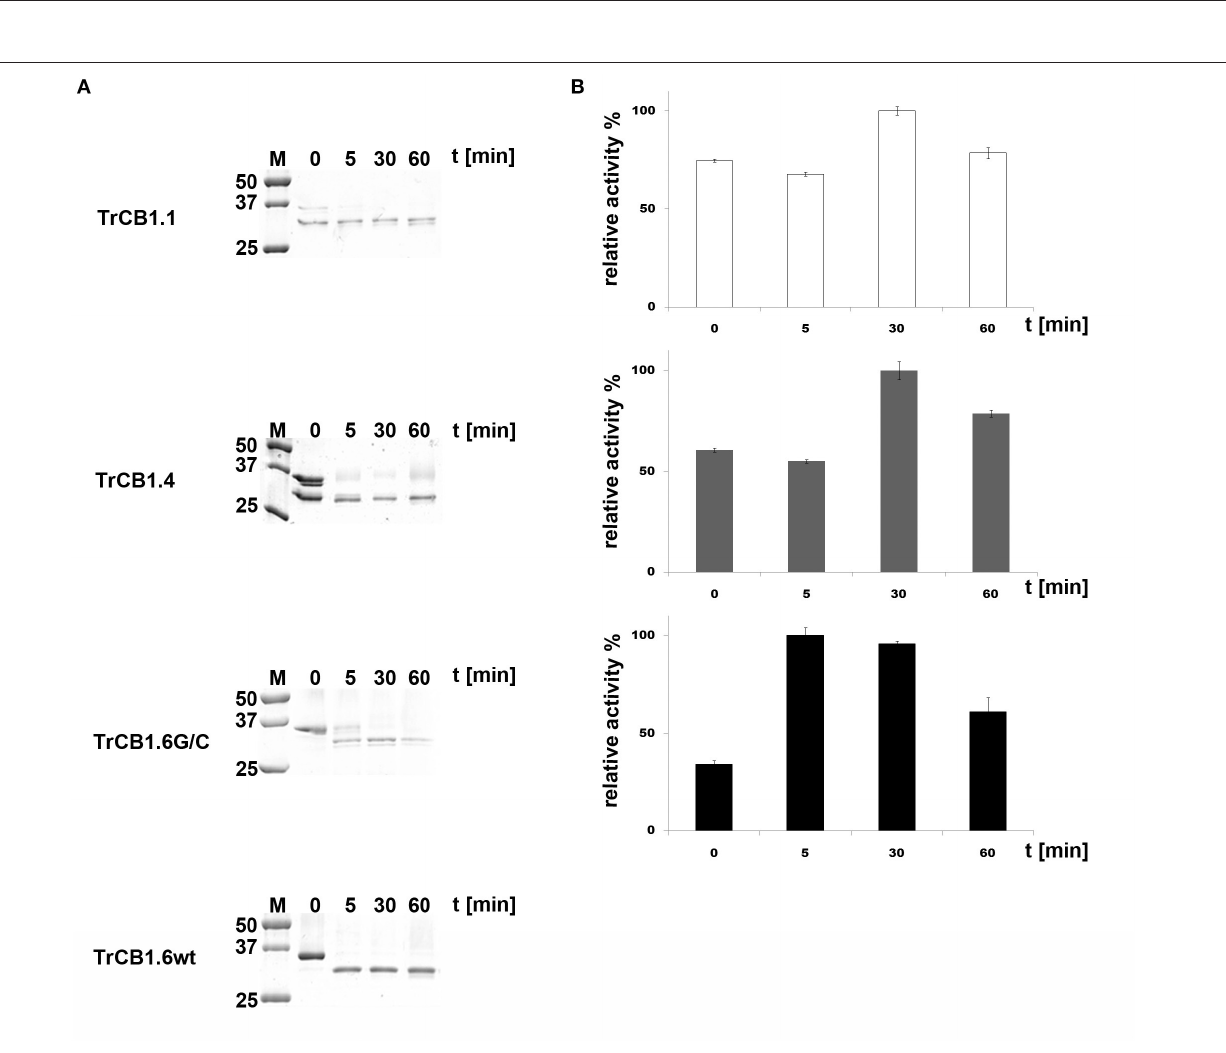
FIGURE 3 | Trans-processing of the TrCB1 zymogens by pepsin. TrCB1 forms were treated with pepsin immobilized on agarose beads at 37 ◦ C (TrCB1.6G/C at RT), and the reaction mixtures were analyzed at the indicated time points. (A) The processed forms were resolved by SDS-PAGE. M, markers of molecular size. (B) Peptidolytic activities of TrCB1.1, TrCB1.4, TrCB1.6G/C generated after processing were measured in a kinetic assay with the substrate Z-Phe-Arg-AMC (25 µ M). The results are means ± SD of two triplicate assays and are expressed as percentage of relative activity in the sample.